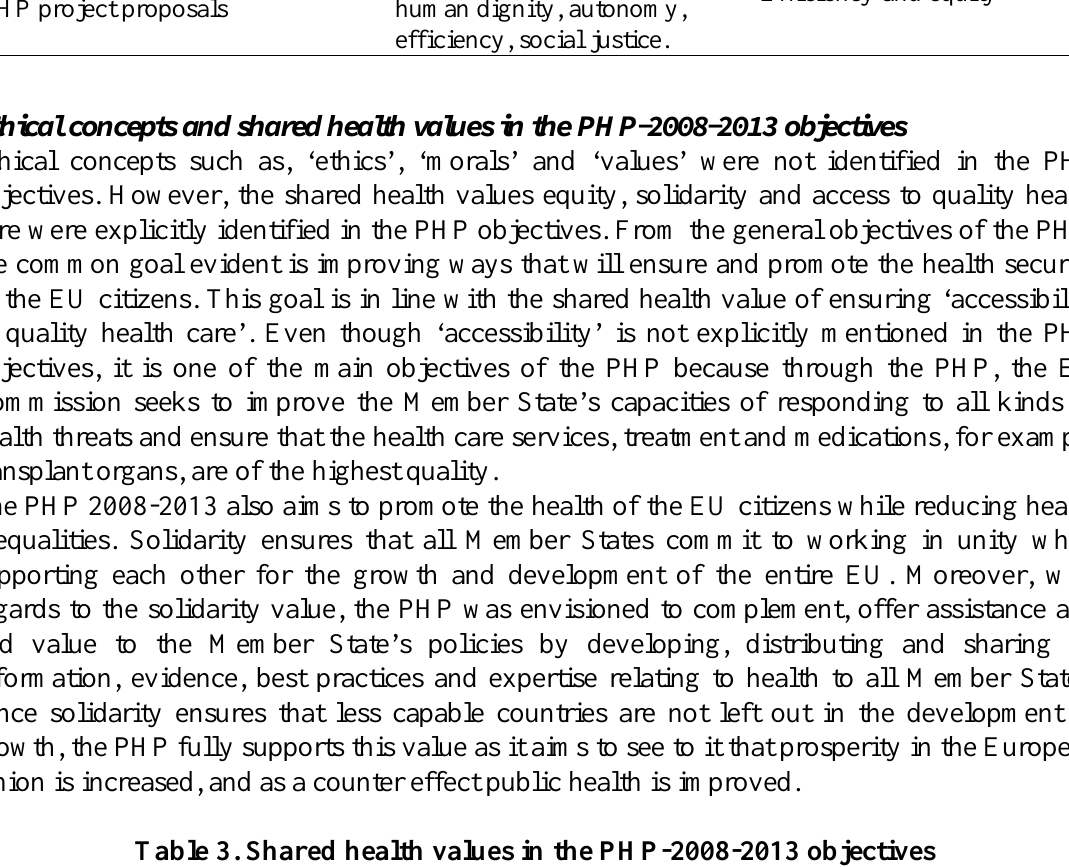
Table 3. Shared health values in the PHP-2008-2013